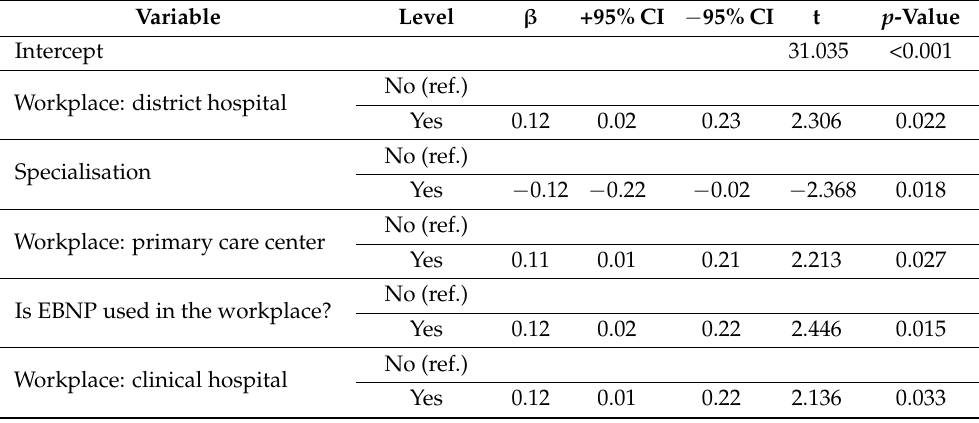
Table 11. Regression analysis for the stepwise model for the subscale ‘Attitude towards selected aspects of EBNP at